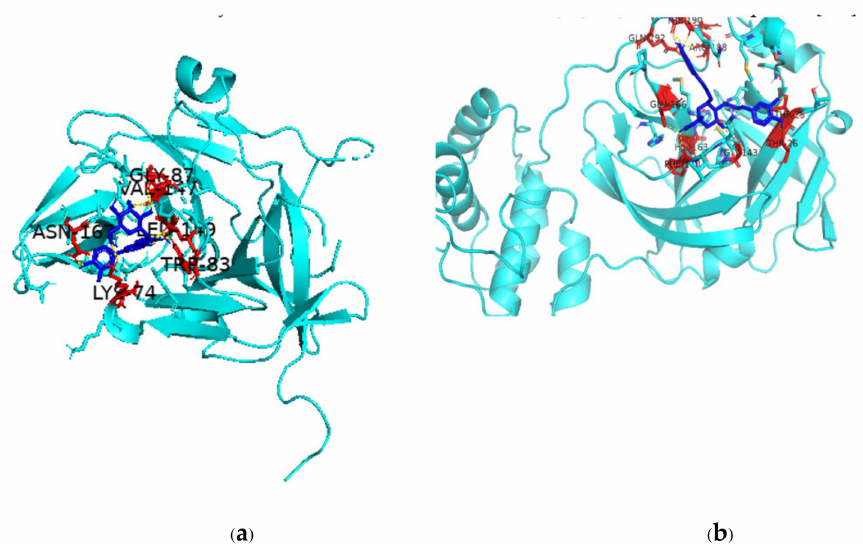
Figure 3. PyMol depiction of binding of flavonoids to DENV-2 NS2B-NS3 and SARS-CoV-2 Mpro ( a ) Binding of NS2B-NS3 activator-protein complex with luteolin-7- O -glucoside; ( b ) binding of rutin with Mpro. Protein is shown in cyan color, ligand as blue-colored stick structure, red-colored amino acids are involved in polar interactions with the